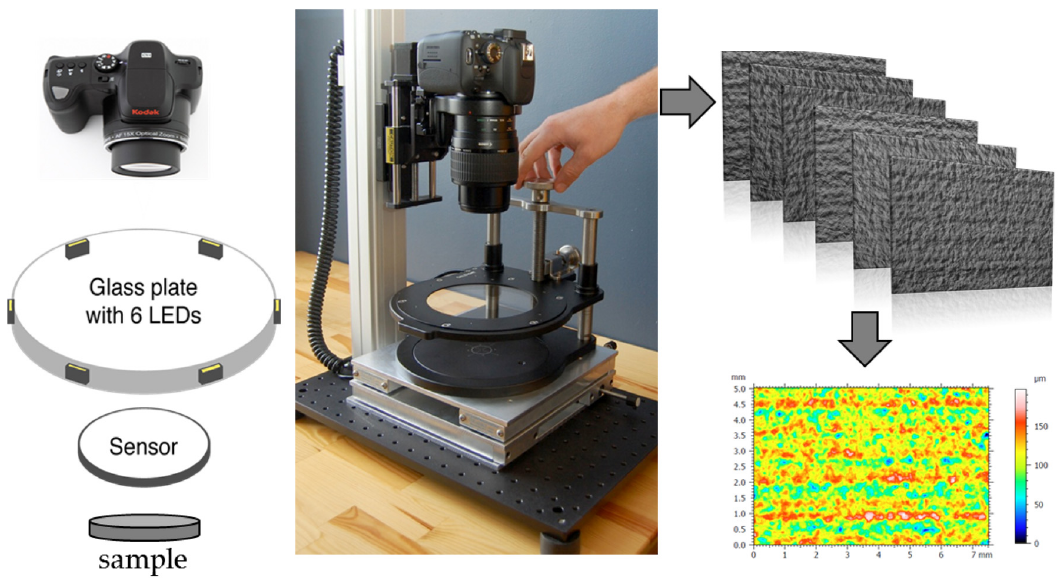
Figure 4. GelSight measurements with greyscale pictures and a calculated surface height map.